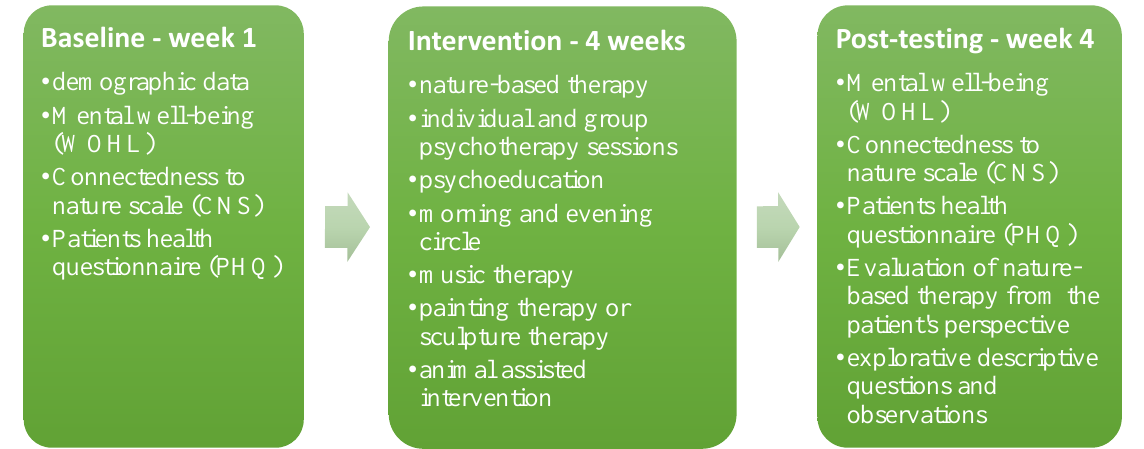
Figure 1. Visualization of the study design about how research was being conducted (including measurement tools, integrative therapy program, and time of the research).